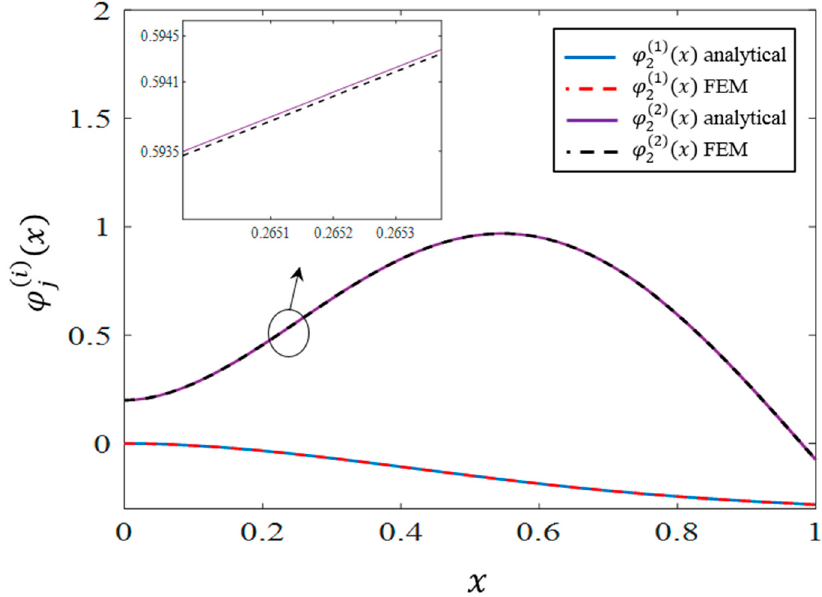
Figure 3. Comparison of the analytical and numerical shapes corresponding to the second mode.